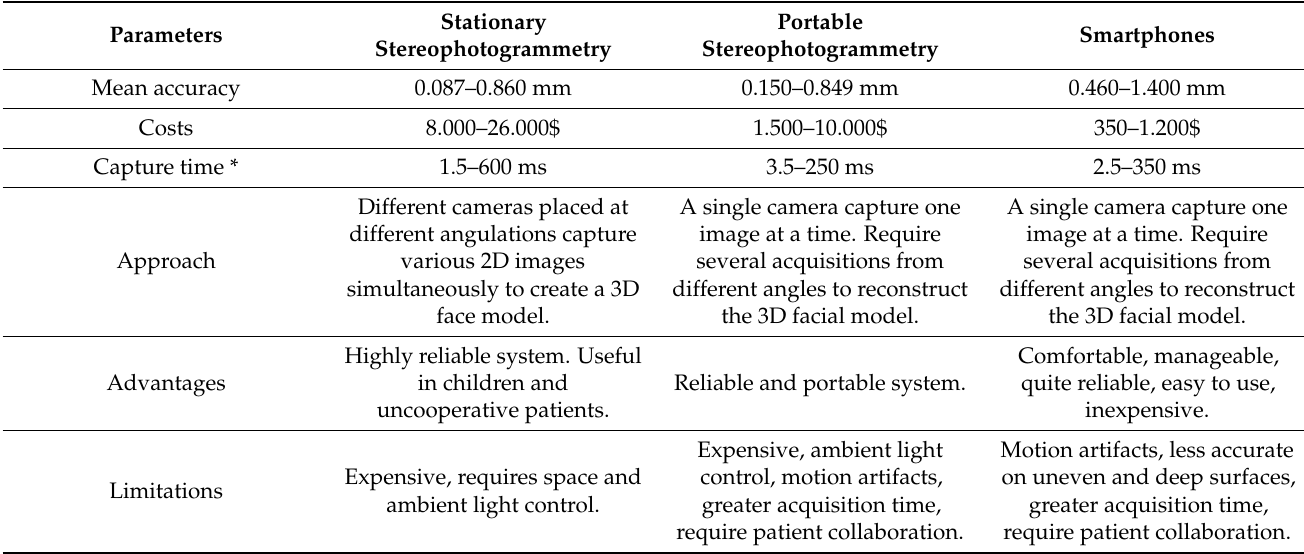
Table 5. Comparison of stationary/portable stereophotogrammetry and smartphone scanning face